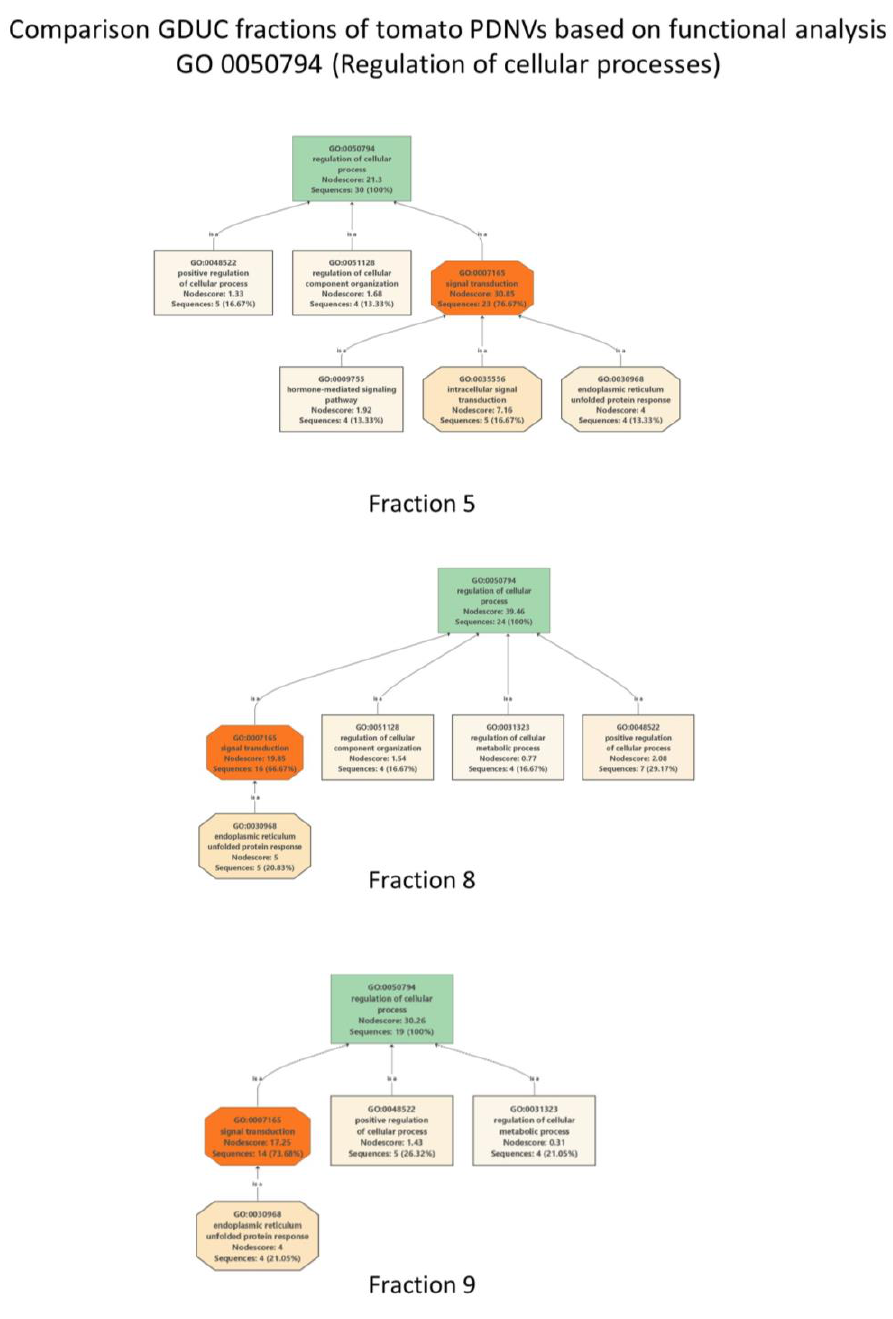
Figure 4. Acyclic directed graphs of GO:0050794 term in density gradient ultracentrifugation separated visible fractions (Fraction 5, Fraction 8 and Fraction 9) of tomato nanovesicles. Graph was filtered by four sequences. The node score is the sum of sequences directly or indirectly associated to a GO term weighted by the distance of the term to the term of “direct annotation”, i.e., the GO term the sequence is originally annotated to.